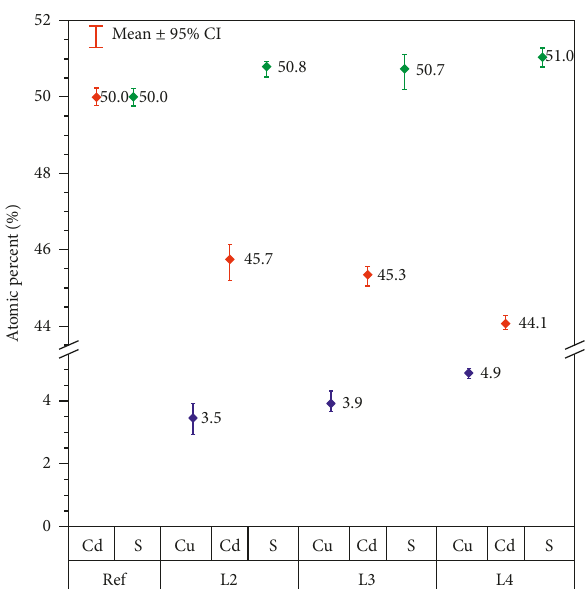
Figure 5: Elemental composition of CdS: Cu films obtained by ionic exchange process in aqueous solution.